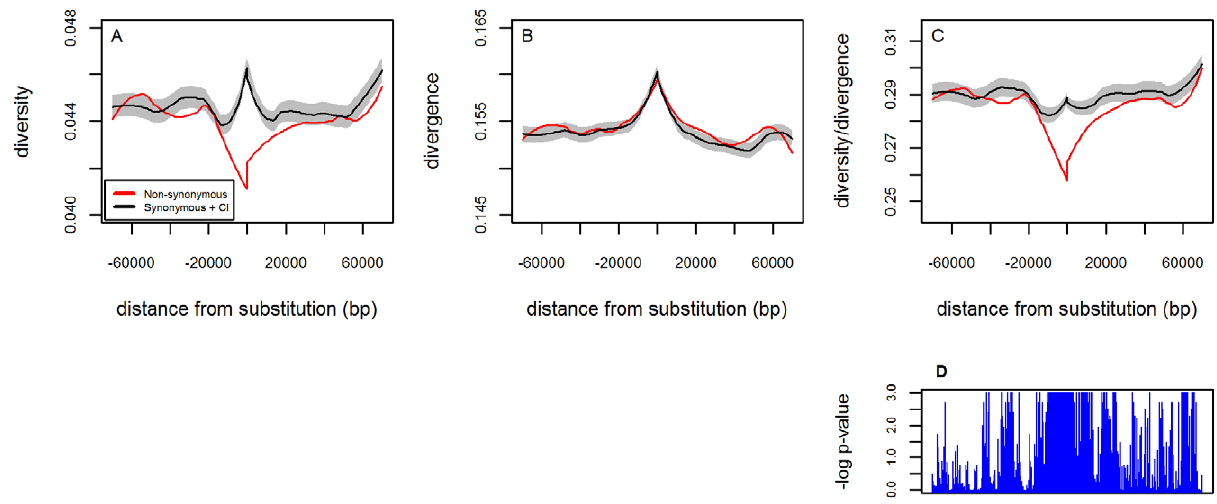
Figure 1. The footprint of beneficial amino acid substitutions in neutral levels of diversity. A. Average synonymous diversity level in D. simulans as a function of distance from amino acid (red) and synonymous (black) substitutions in the D. simulans lineage. B. Average synonymous divergence between D. melanogaster and D. yakuba (a proxy for the mutation rate) as a function of distance from amino acid (red) and synonymous (black) substitutions. C. Synonymous diversity levels divided by divergence as a function of distance from amino acid (red) and synonymous (black) substitutions (see Text S1). The curves in A–B were smoothed with LOESS on the left and right of substitutions separately, and C was calculated as a ratio of the value after smoothing (see Text S1). The gray sleeves represent the standard error of the mean of the synonymous control (black curve) estimated from 1000 bootstraps and smoothed by LOESS as above (see Text S1). D. A Manhattan plot of the one tailed p-value (on a logarithmic scale) testing the hypothesis that the average diversity divided by the average divergence around amino acid substitutions is the same as that around synonymous substitutions (shown in C). Results are shown as a function of distance from the substitution (based on 1000 bootstraps and calculated in bins of 0.5 kb; see Text S1 for details). substitutions around amino acid substitutions (Figure 2A: black), implying that it is caused by more than the spatial distribution of acid substitutions. The difference between the clustering of amino